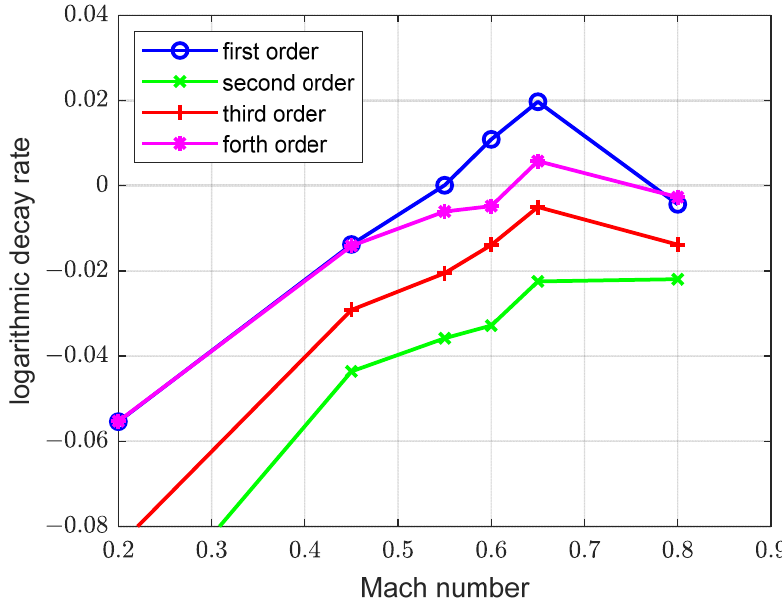
 . The FSI-induced vi-